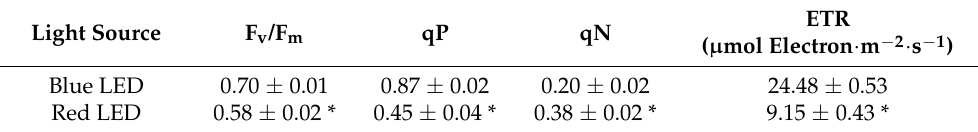
Table 2. The maximal quantum yield of PSII (F v /F m ), photochemical fluorescence quenching coeffi- cient, non-photochemical fluorescence quenching coefficient, and electron transfer rate of H. corymbosa (L.) Lam leaves after 4 weeks of growth under different light sources at 100 µ mol · m − 2 · s − 1 light intensity.